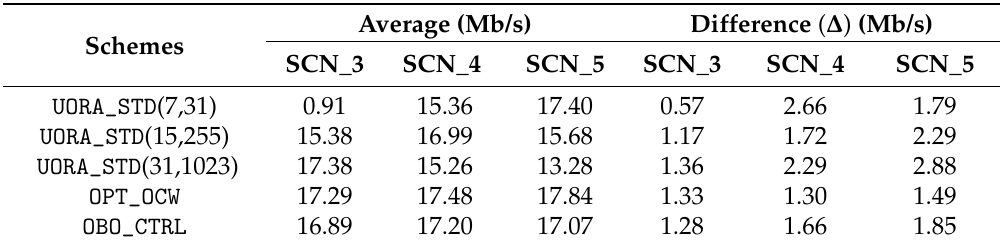
Figure 5. Throughput comparison of UORA schemes under dynamic network conditions: ( a ) sce- nario 3, ( b ) scenario 4, and ( c ) scenario 5. Table 3. The average throughput and the difference between the 95th and 5th percentiles of the throughput of the UORA schemes under dynamic network scenarios